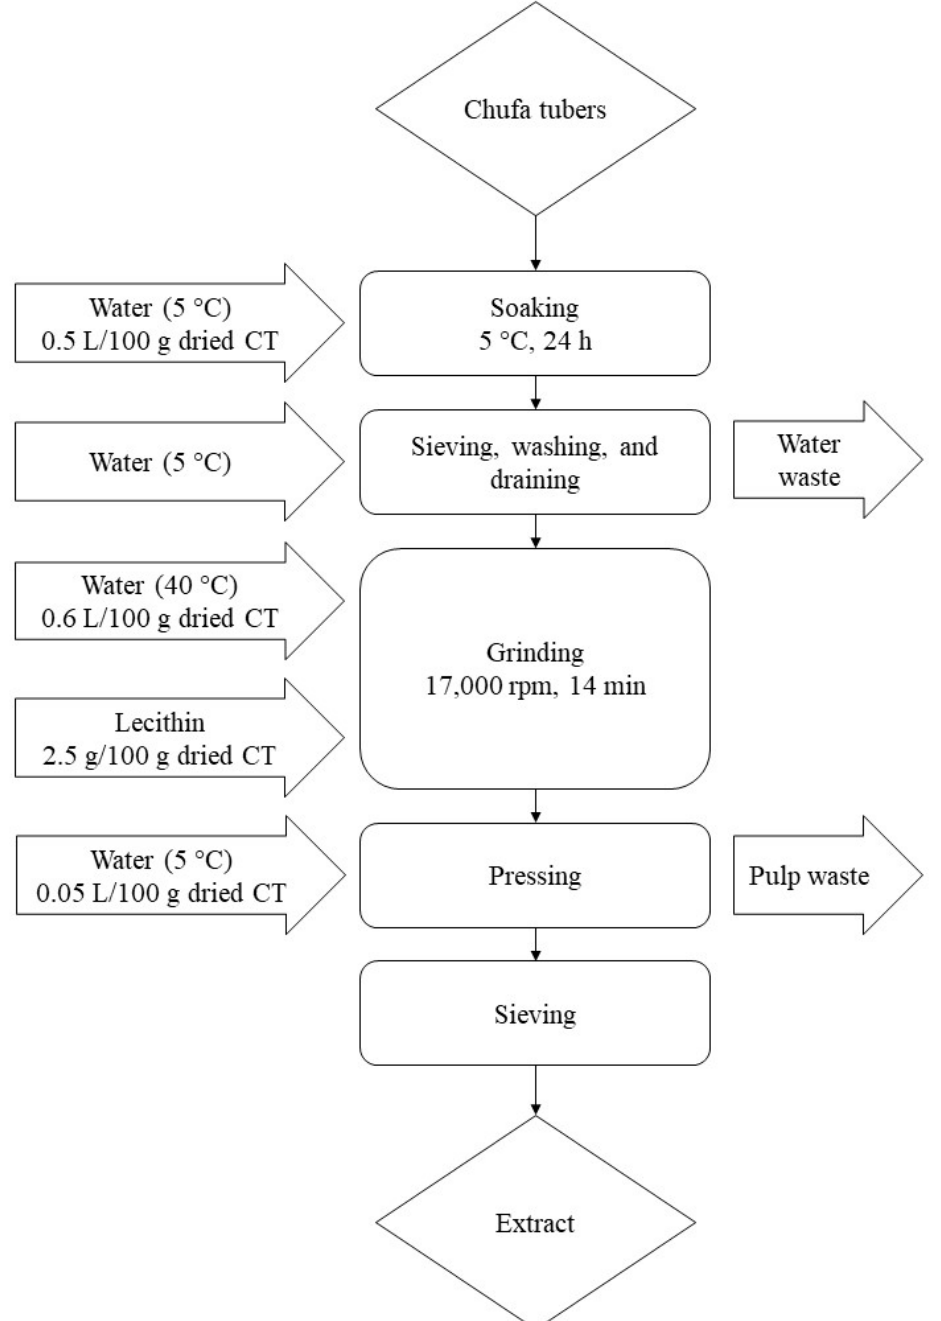
Figure 1. Flowchart of the process of producing the chufa-based liquid extract.